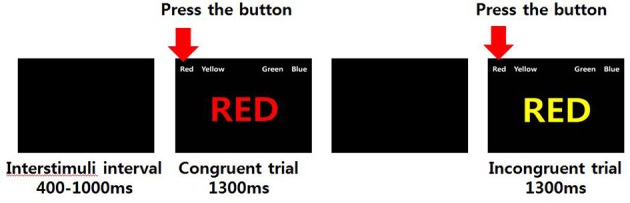
Examples of congruent and incongruent conditions in the Stroop task.